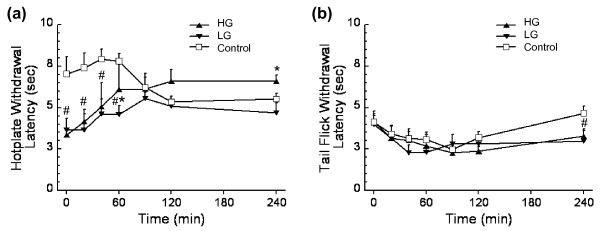
Central thermal hyperalgesia in high-fat-fed mice at 53 weeks of age. (a) Paw-withdrawal latency durations versus time for a hotplate test of centrally-mediated thermal hyperalgesia. High-fat (HF)-fed mice showed thermal hyperalgesia for the first 60 minutes of hotplate testing. (b) Tail-flick latency over time for a test of peripherally-mediated thermal hyperalgesia. HF-fed mice showed thermal hyperalgesia at 240 minutes of tail-flick testing. Data shown as mean ± standard error of the mean. *P < 0.05 for comparison with time-matched control value for either the low gainer (LG) group or the high gainer (HG) group. #P < 0.05 for time-matched HF diet versus control comparison.